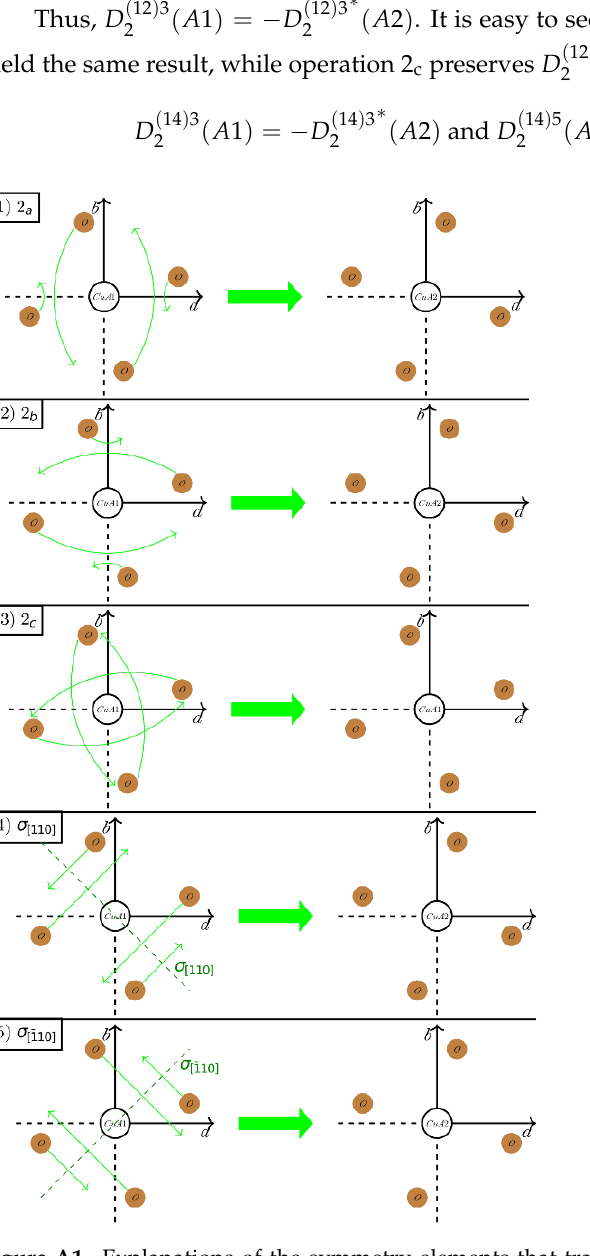
Figure A1. Explanations of the symmetry elements that transform the Cu(A1) position into the Cu(A2) position.